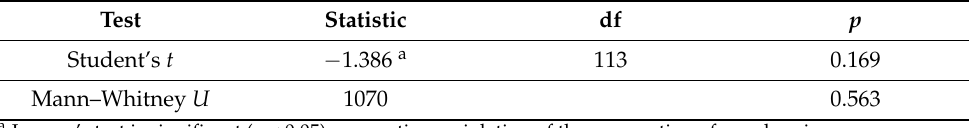
Table 6. Independent samples comparisons (Absent, Present) for the variable “Elastosis”.